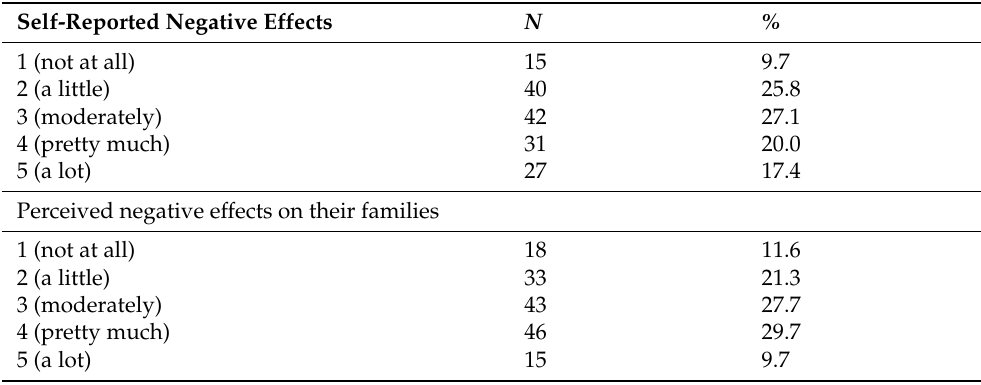
Table 2. Self-reported and perceived adverse effects of the COVID-19 pandemic ( N = 155).